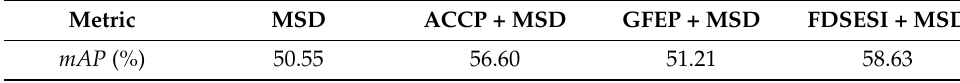
Table 3. Ablation study of proposed methods on the SDS